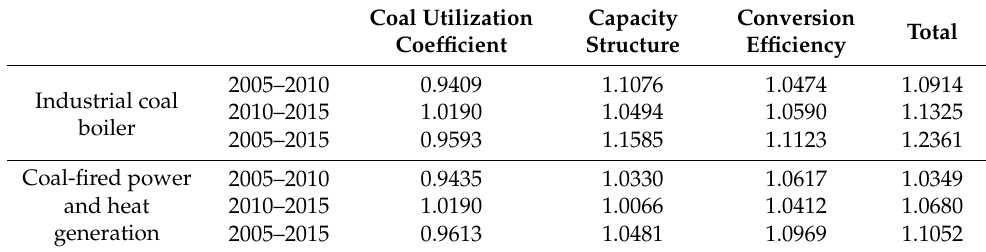
Table 3. LMDI decomposition results of the “Dual Structure” problem in China.